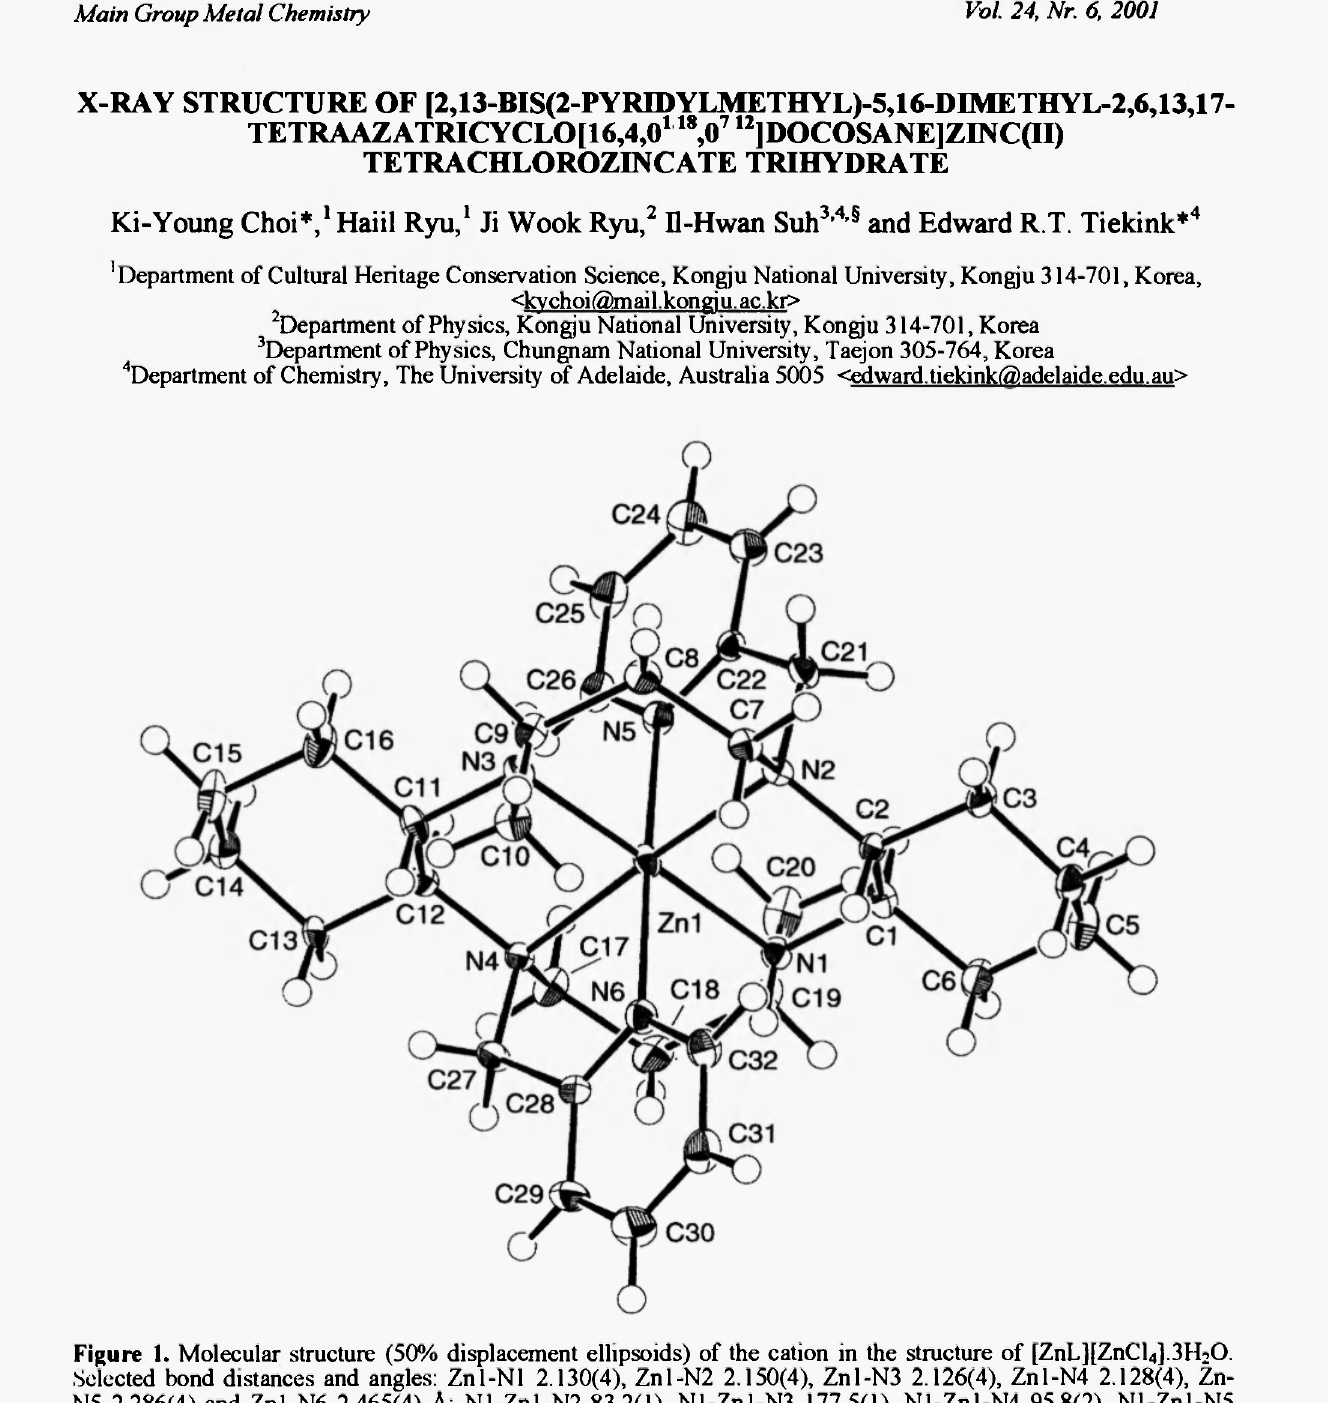
Figure 1. Molecular structure (50% displacement ellipsoids) of the cation in the structure of [Ζηί][Ζη0 4 ].3Η 2 0. Selected bond distances and angles: Znl-Nl 2.130(4), Znl-N2 2.150(4), Znl-N3 2.126(4), Znl-N4 2.128(4), Zn- N5 2.286(4) and Znl-N6 2.465(4) A; Nl-Znl-N2 83.2(1), Nl-Znl-N3 177.5(1), Nl-Znl-N4 95.8(2), Nl-Znl-N5 97.6(1), Nl-Znl-N6 80.6(1), N2-Znl-N3 96.2(1), N2-Znl-N4 176.4(1), N2-Znl-N5 80.2(1), N2-Znl-N6